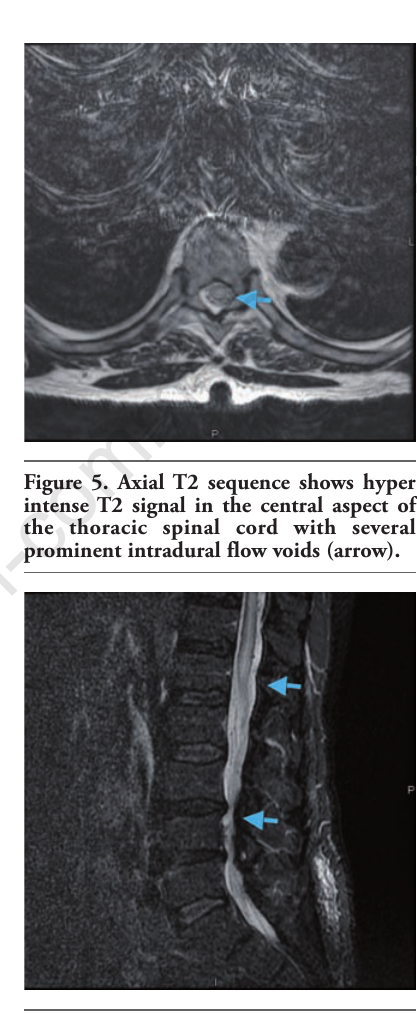
Figure 7. Sagittal T2-weighted sequence shows hyper intense abnormality through- out the conus medullaris with sparing of the periphery. Multiple intradural flow voids are seen from the level of the conus medullaris down to the cauda equina nerve roots (arrows).